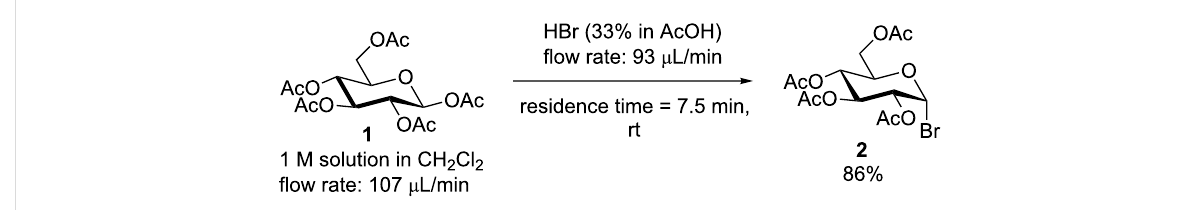
HBr in acetic acid (33%) and PP reactor R3. It should be noted that the reactor material withstood the harsh acidic conditions.